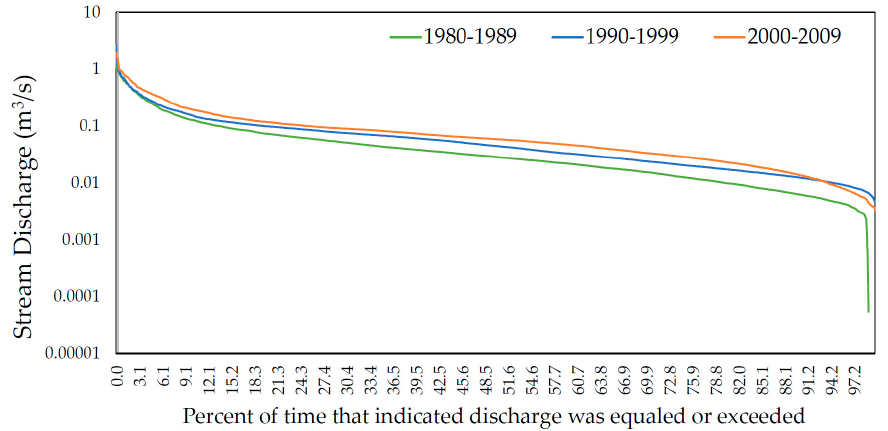
Figure 5. Simulated flow duration curves by decade generated by the SWAT model with the hydroclimatological component. Stream discharge is equal to zero at the 100th percentile.